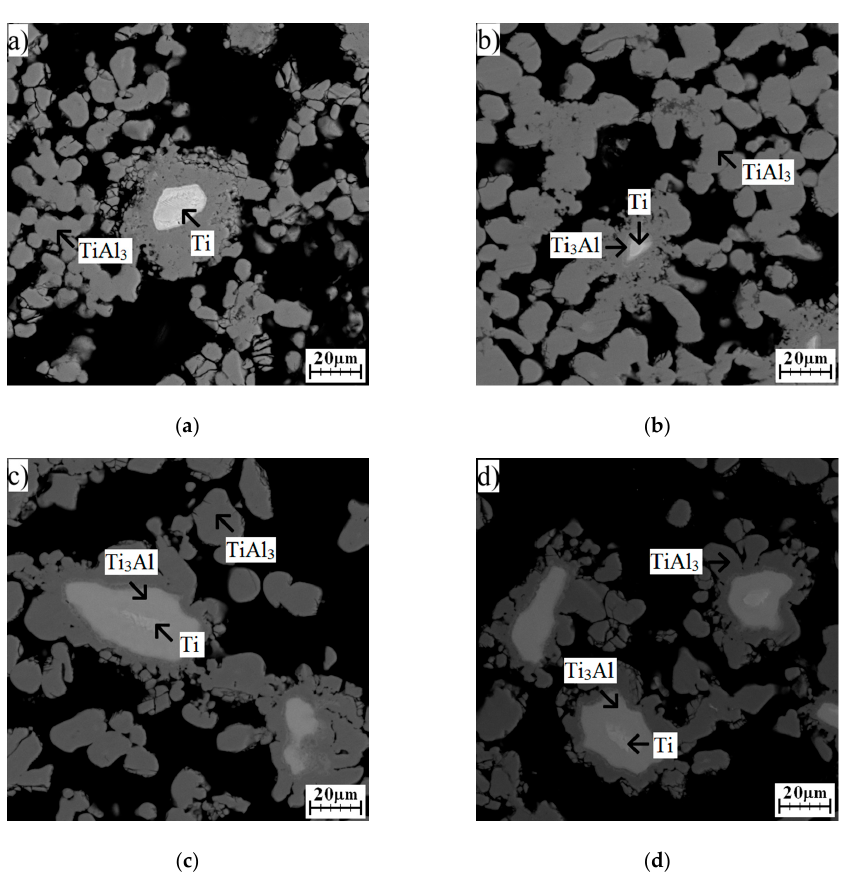
Figure 2. The microstructures obtained at various heating rates: ( a ) 19 °C/min, ( b ) 59 °C/min, ( c ) 89 °C/min, and ( d ) 102 °C/min.